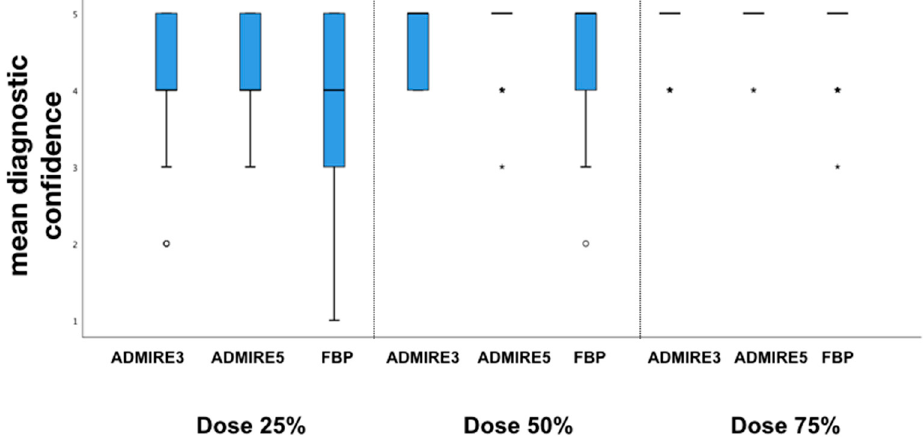
Figure 4. Mean diagnostic confidence. Box-and-whisker plots at different dose levels of overall diagnostic confidence in detection of cervical abscess.